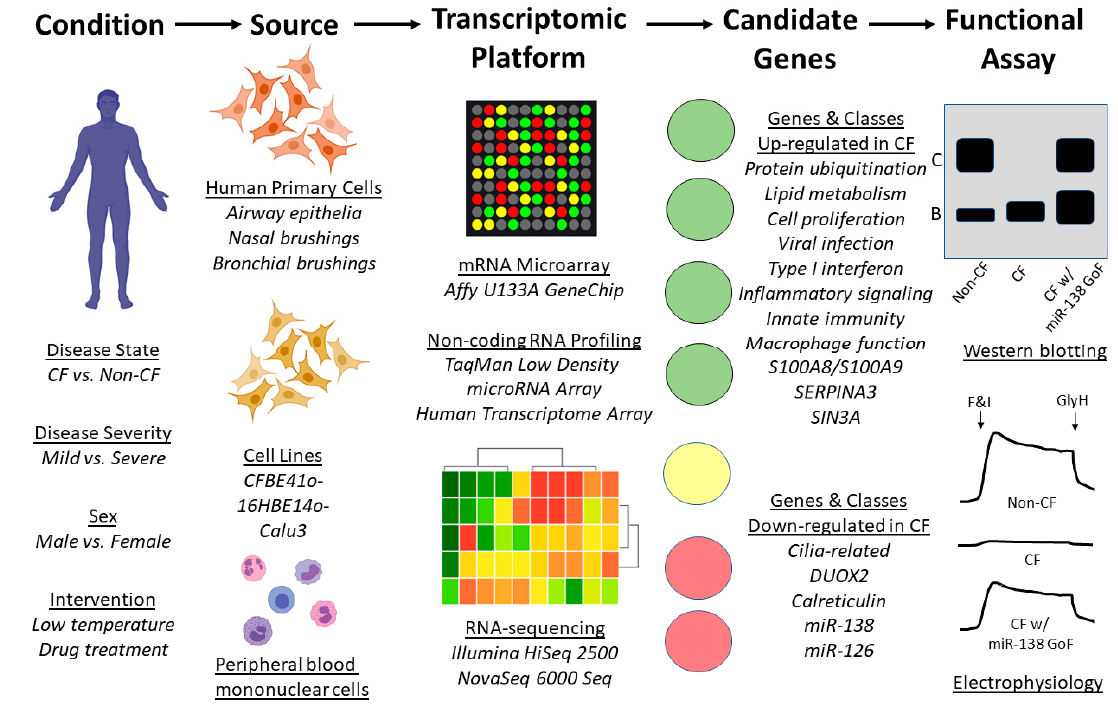
Figure 3. Workflow of transcriptomic profiling. To identify transcriptomic changes resulting from cystic fibrosis (e.g., disease presence or severity), multiple primary and immortalized cell sources are available, as are several profiling platforms. Analysis of profiling output reveals differentially expressed genes (DEGs) and gene classes; findings highlighted in the text are shown under “Candidate Genes”. The effects of manipulating DEGs (e.g., gain of function (GoF) can be assessed using multiple assays. Examples of CFTR western blotting and electrophysiology as endpoints are presented with hypothetical data representing overexpression of miR-138 [58]. F&I represent the cyclic AMP agonists forskolin and IBMX. GlyH represents CFTR inhibitor GlyH-101.